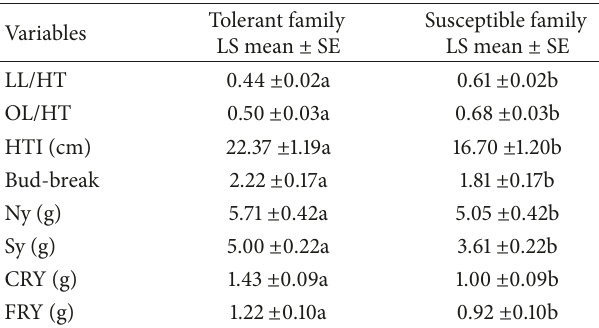
Table 3: Least square means and standard error of various response variables in susceptible and tolerant